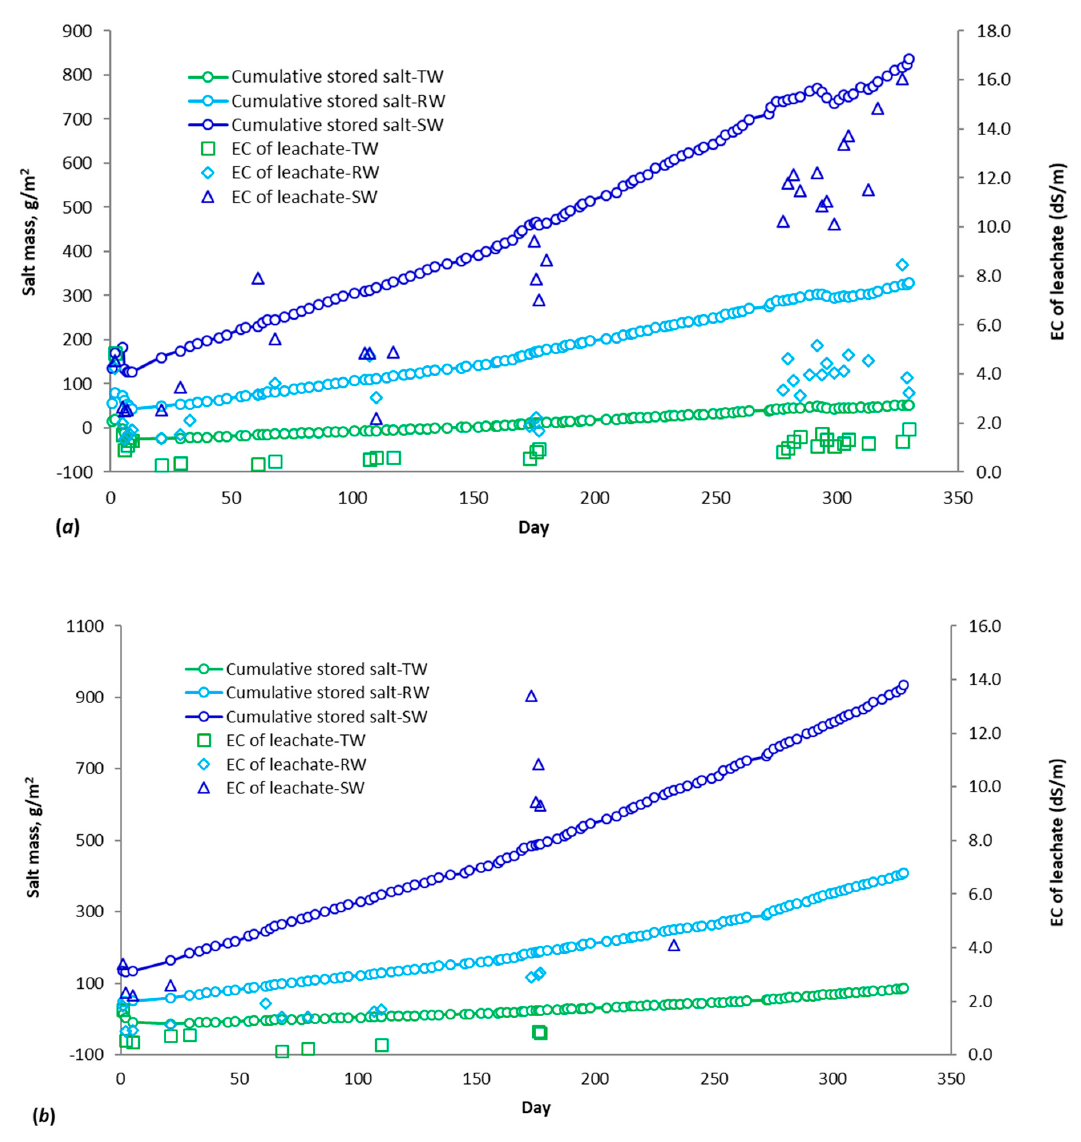
Figure 3. Cumulative salt mass stored in columns (averaged over the results from three columns) and variation of EC of leachate during the study period using TW, RW, and SW as irrigation water for ( a ) D33 paddock soil ( b ) Yarramundi paddock soil.